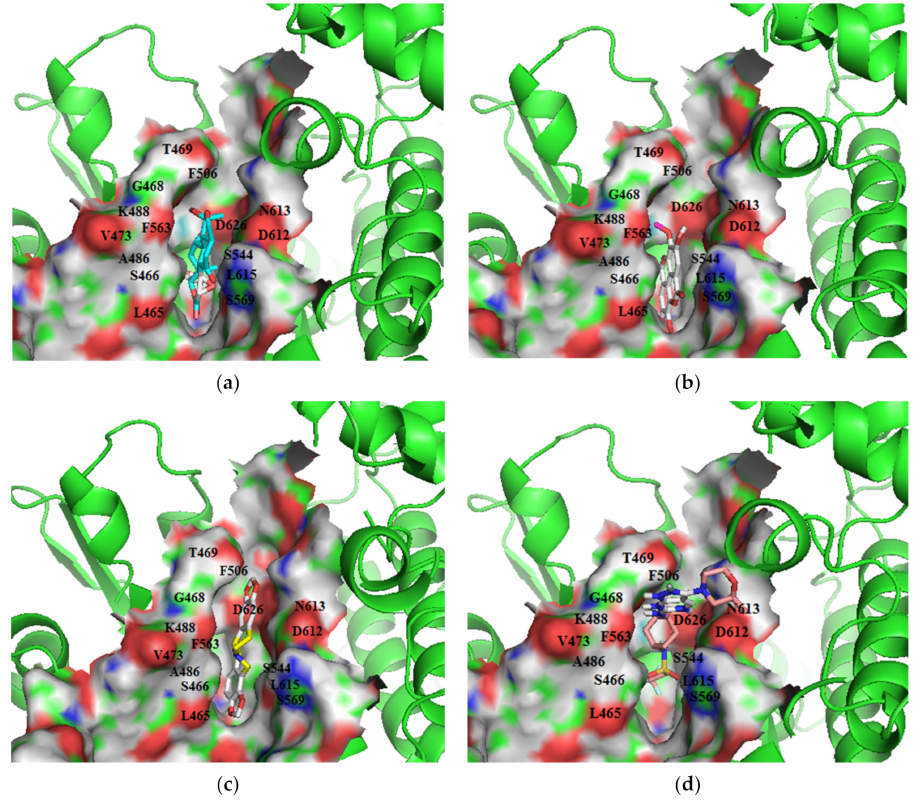
Figure 6. Cartoon representation of Ld CRK12 in complex with: ( a ) ZINC000095485940; ( b ) NAN- PDB1406 (methyl ellagic acid); ( c ) NANPDB2581 (stylopine); and ( d ) GSK3186899 (Compound 7). The binding site is shown as surface representation with the ligands shown as